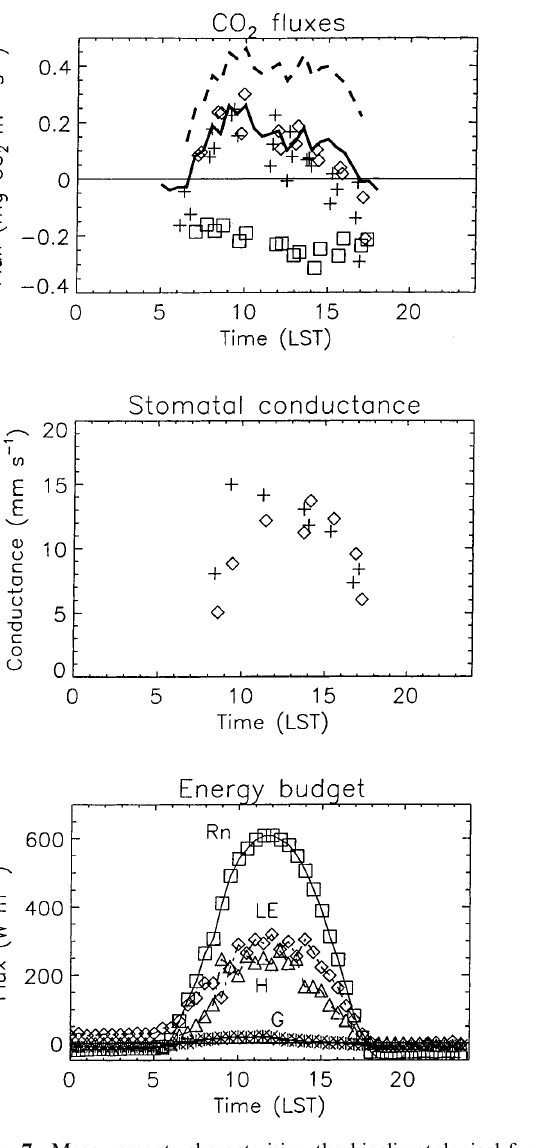
Fig. 7. Measurements characterising the bioclimatological function- and soil respiration. In situ measurements of leaf stomatal conduc- ing of the MUREX fallow on DoY 247 in 1997. The atmospheric tance are obtained over Potentilla - and Brachypodium -dominated CO flux and concentration are measured at 2.7 m above the soil spots ( pluses and diamonds , respectively). The surface temperature is 2 surface ( solid lines ); chamber measurements of the net CO flux are either infrared-derived ( thick line ) or measured in the soil ( dashed line ), 2 obtained over Potentilla - and Brachypodium -dominated spots ( pluses here at 5-cm. The energy budget is given by the SAMER system (net and diamonds , respectively); the negative CO flux represented by radiation Rn ; heat flux H : latent heat flux LE ; and ground heat flux 2 boxes corresponds to chamber measurements of soil respiration. The G). The air saturation deficit ( dashed line ) is obtained from screen- CO level air temperature and humidity data, and the deficit at the surface flux represented by the dashed line is an estimation of daytime net 2 ( solid thick line ) is computed from the assimilation given by the di(cid:128)erence between the atmospheric CO flux 2